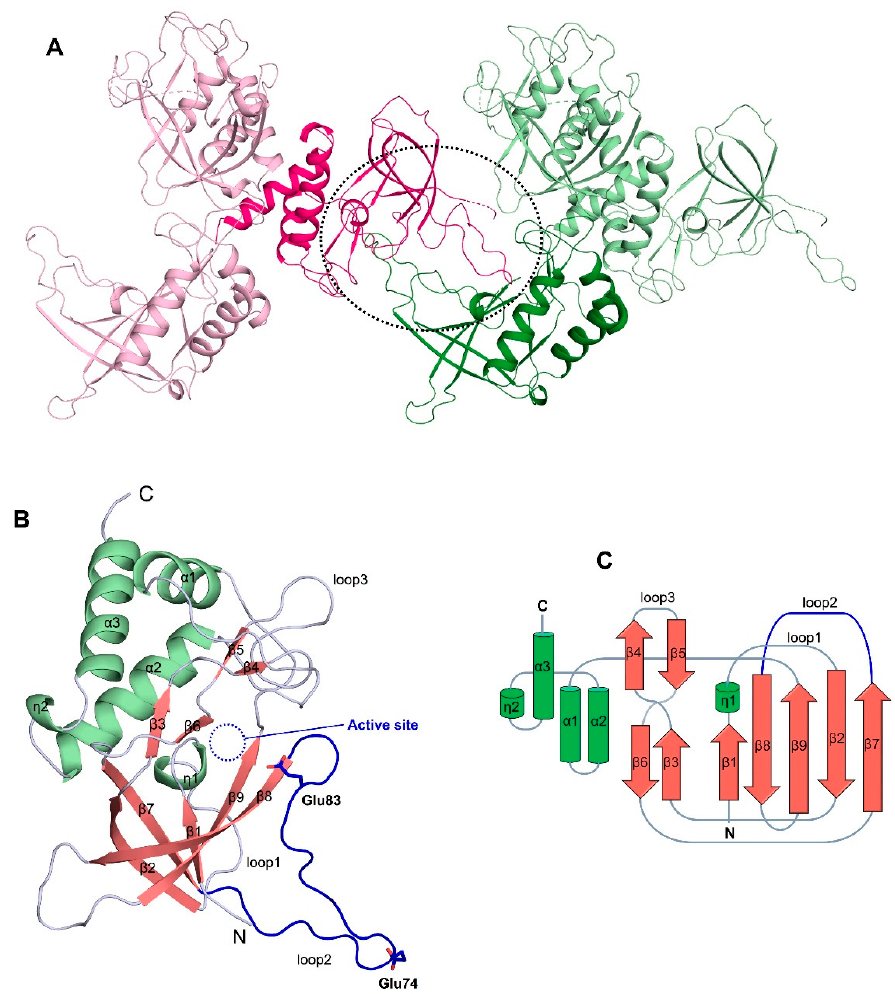
Figure 1. Overall structure of ChaC2. ( A ) Schematic representation of ChaC2 molecules in the crystal. ChaC2 molecules of the crystallographic dimer from two nearby an asymmetric unit (ASU) are colored in pink and green, respectively. The crystallographic dimer formed by flexible loop2 is denoted with a black dotted circle. ( B ) Structure of ChaC2. Helices, β -strands, and loops are colored in green, salmon, and light blue, respectively. The active site of ChaC2 is donated with a blue dotted circle. Loop2 is colored in blue. The side chains of Glu74 and Glu83 are shown as stick models. ( C ) Topology diagram of ChaC2. The secondary structure elements are denoted as in ( B ).